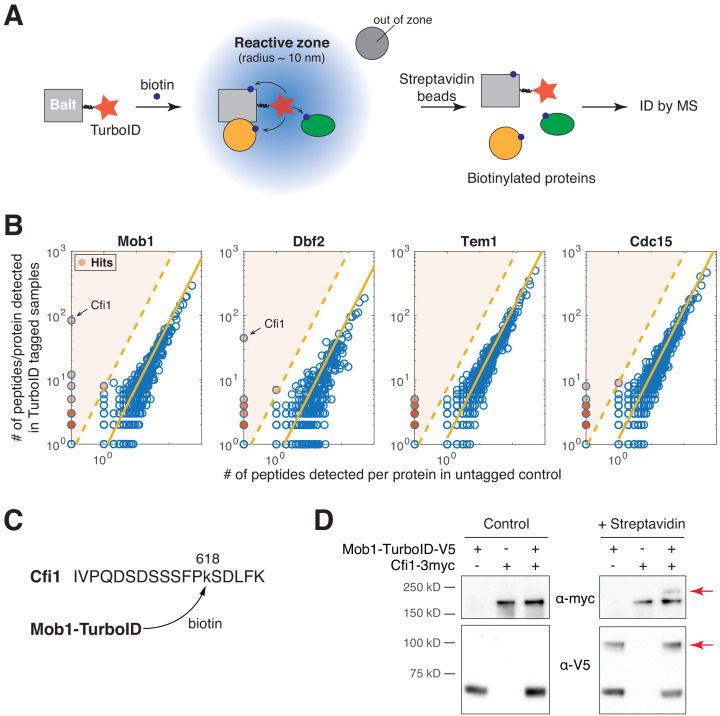
TurboID identified interaction between Dbf2-Mob1 and Cfi1/Net1.(A) Overview of TurboID proximity-based biotinylation to identify interaction partners of a target protein. (B) Number of total peptides detected for MS-identified proteins in cells with TurboID tagged baits relative to untagged control cells (source data for Figure 2A). Shaded red dots represent proteins (hits) identified as interaction partners of the bait protein. Solid yellow lines denote the mean ratio of total peptide detected for all proteins. Dashed lines denote the threshold used for identifying hits (10 standard derivations above the mean). (C) Biotinylated peptide of Cfi1/Net1 detected in cells harboring Mob1-TurboID. (D) Streptavidin gel-shift assay to probe the interaction between Mob1 and Cfi1/Net1. Lysates of A41379, A1638, and A41372 cells with or without streptavidin treatment were immunoblotted as indicated. Red arrows highlight biotinylated proteins.